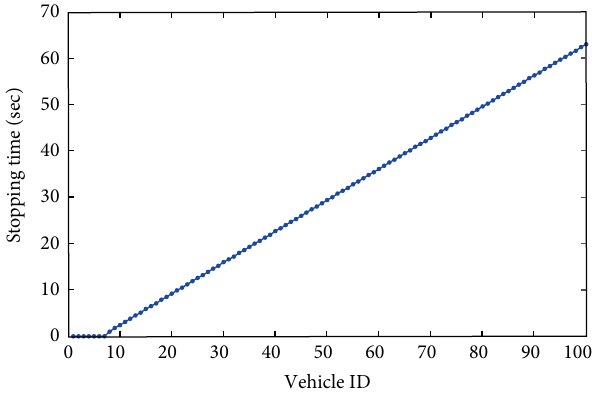
Figure 4: Stopping time of vehicles in upstream